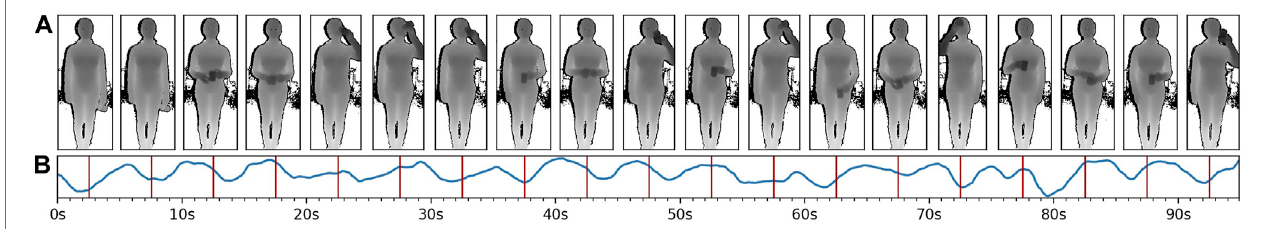
FIGURE 1 | An example of depth-based respiration estimation, taken from a distance of 2 m. The different frames of a depth recording are drawn on the (A) , startingat 2.5 swithan equalspacingof5 s. Thebreathingsignal asestimated from amodel-based approach isdrawn onthe (B) . Red markersindicate thetime points at which the respective frame above the marker was captured. In general, the user can be anywhere in the frame, and the model-based approach allows the user to perform activities that self-occlude the torso. An overview of the model-based as well as various other types of state-of-the-art depth-based respiration estimation methods will be presented in Section 3